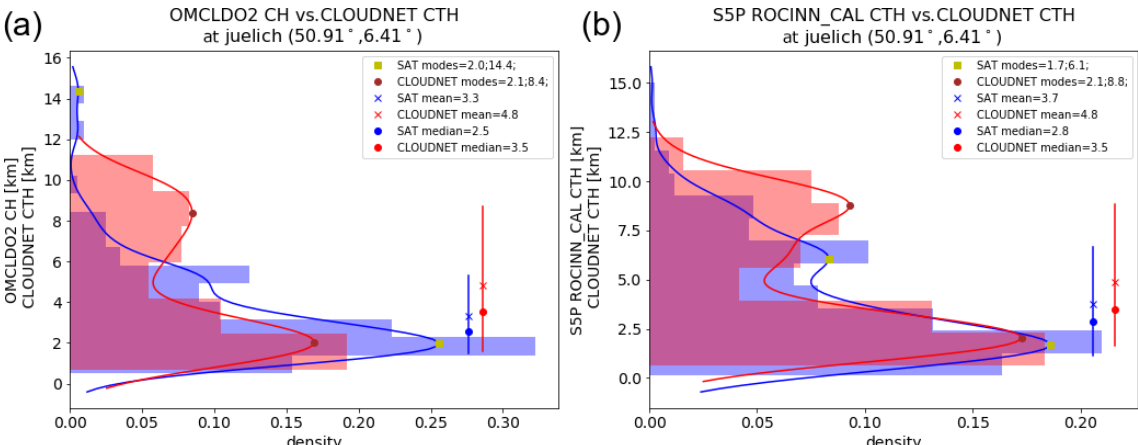
Figure 9. Normed histograms of satellite-Cloudnet co-located cloud height or cloud-top height, with superimposed density estimates using Gaussian kernels (from the python scipy.stats package), at the site Juelich. Panel (a) shows OMCLDO2 CH vs. Cloudnet CTH and panel (b) shows S5P OCRA/ROCINN_CAL CTH vs. Cloudnet CTH. The most important local modes of the satellite and Cloudnet distributions are indicated as well as the mean and median and the central 68%